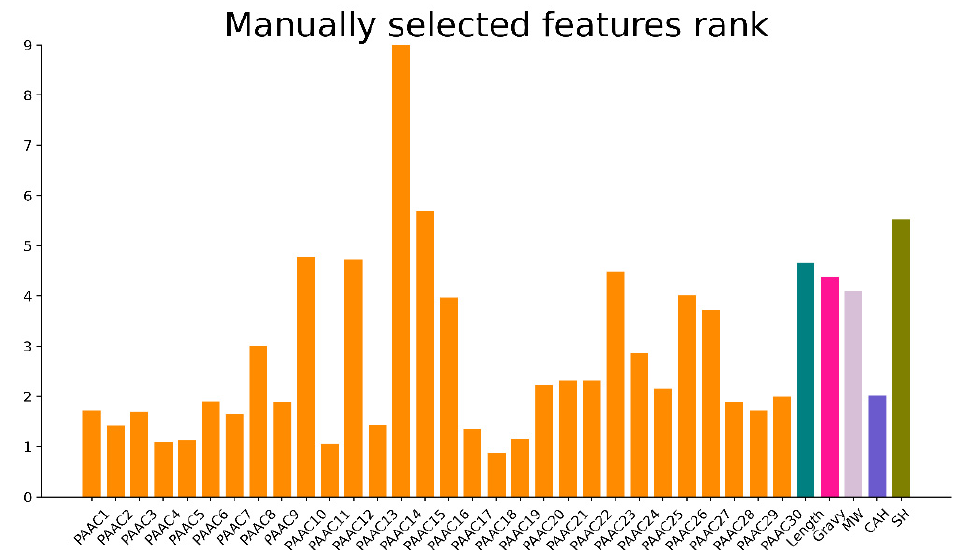
Figure 3. The importance rank of manually selected features.